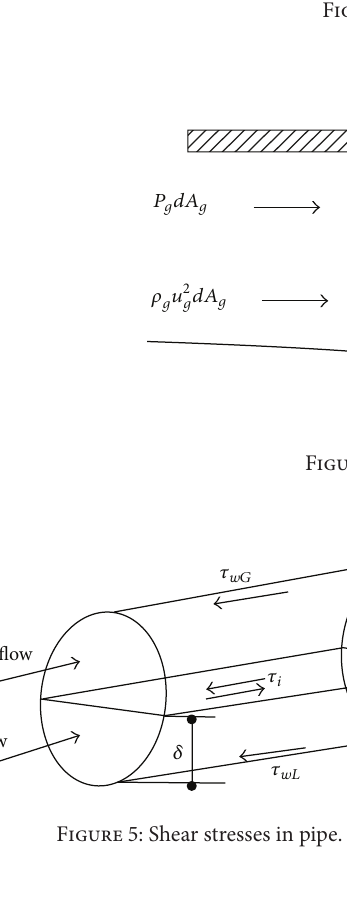
Figure 3: Momentum balance in liquid film.